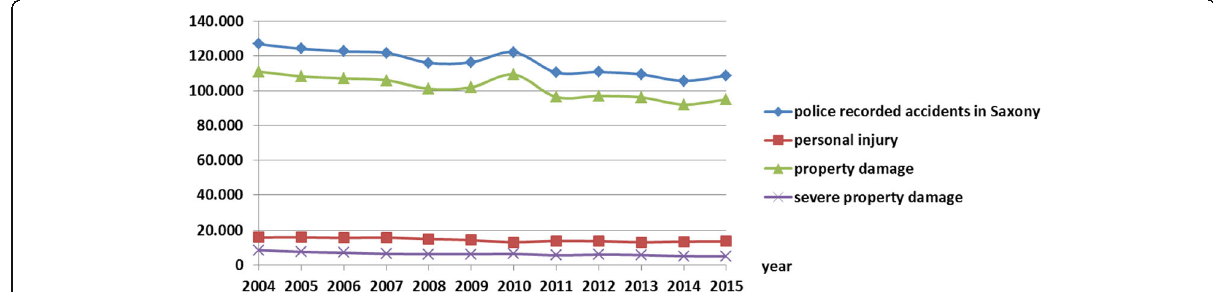
Fig. 7 Area-wide analysis: based on 1,286,109 police recorded accidents in Saxony between 2004 and